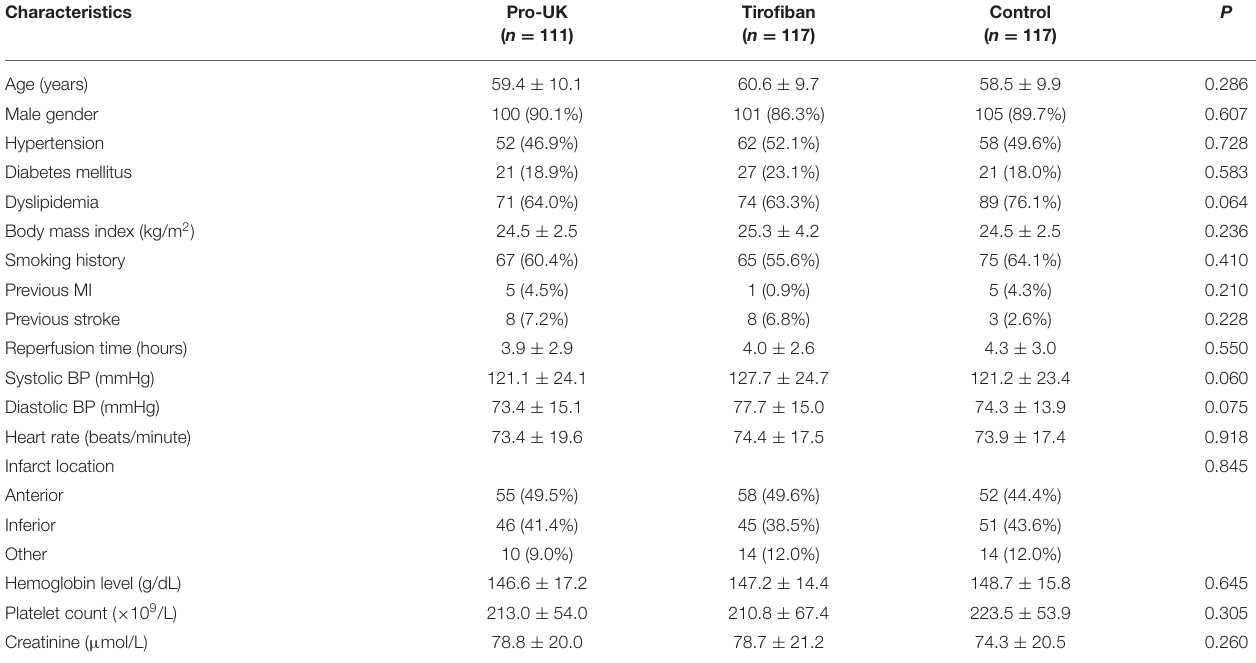
TABLE 1 | Baseline clinical characteristics of the study participants.